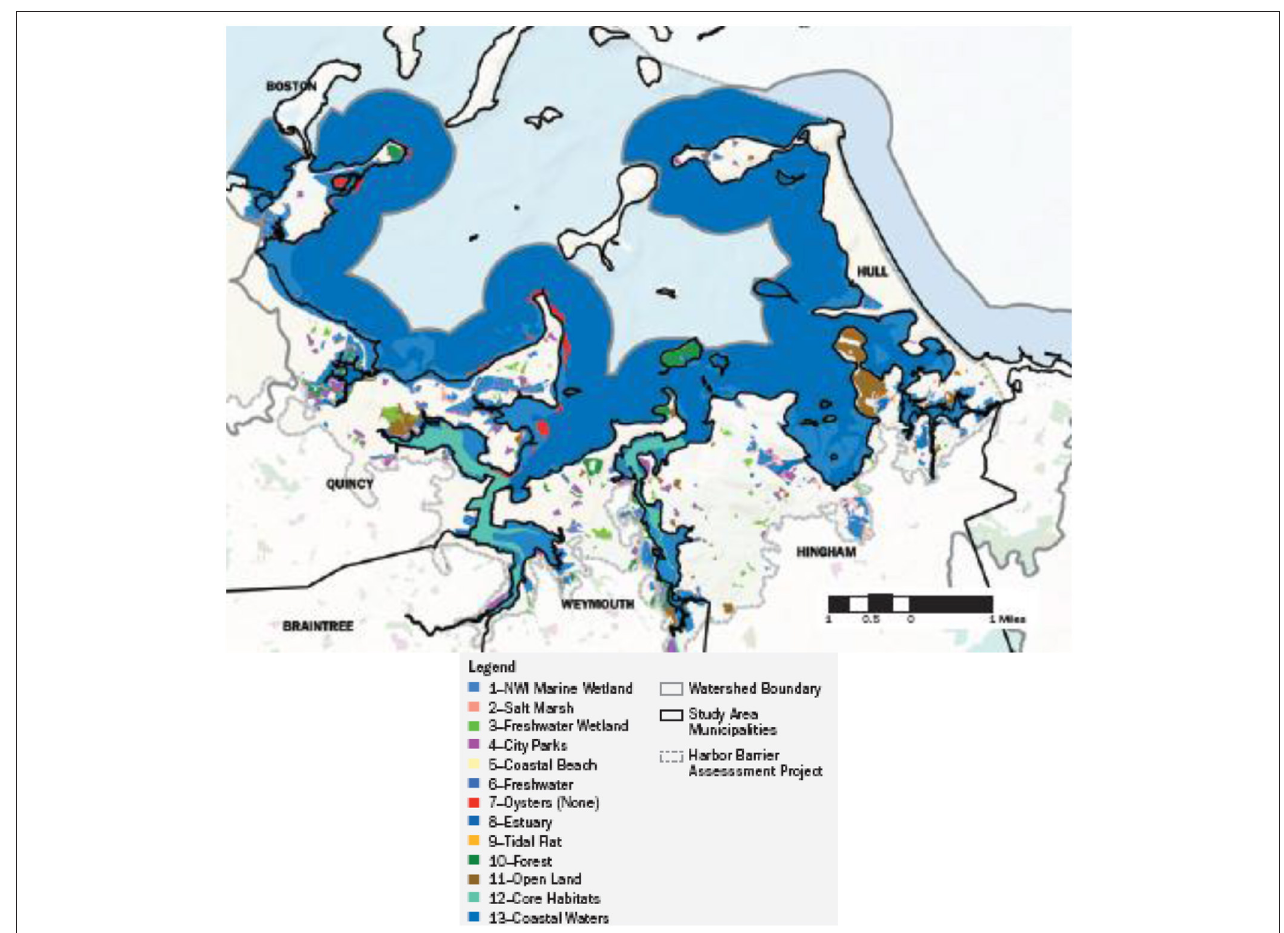
FIGURE 5 | Weir River